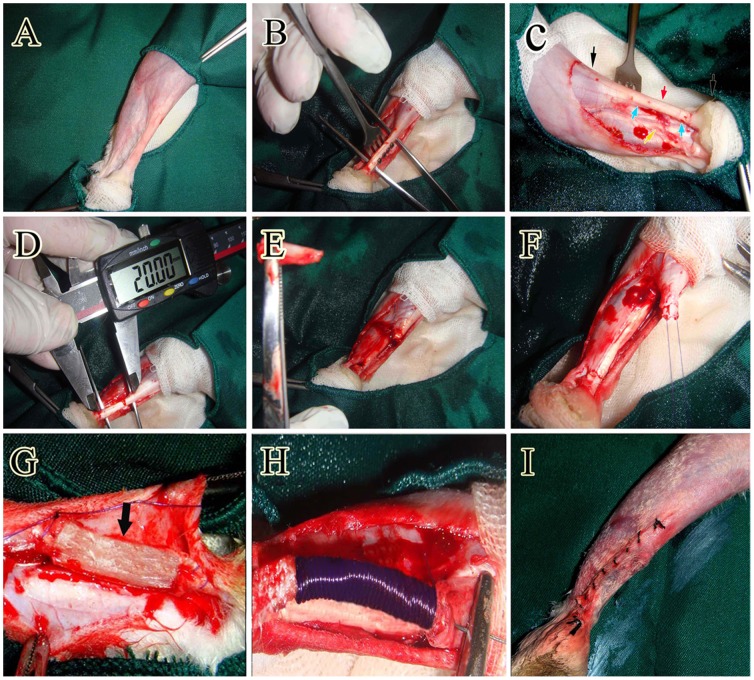
Surgical intervention and implantation of the bioimplant.A: The surgical site and preparation method. B: Skin incision and exposure of the Achilles apparatus. C: Black arrows show the gastro soleus muscle proximally and calcaneal tuberosity distally. The red arrow shows the Achilles apparatus, blue arrows the segment to be removed and the yellow arrow the tibialis posterior tendon. D and E: 2 cm of the Achilles tendon was measured with a digital caliper and removed. F: A modified Kessler Core pattern suture was anchored in the ends of the remaining tendon. G and H: The collagen and collagen PDS implants were inserted. I: The skin over the lesion was closed.